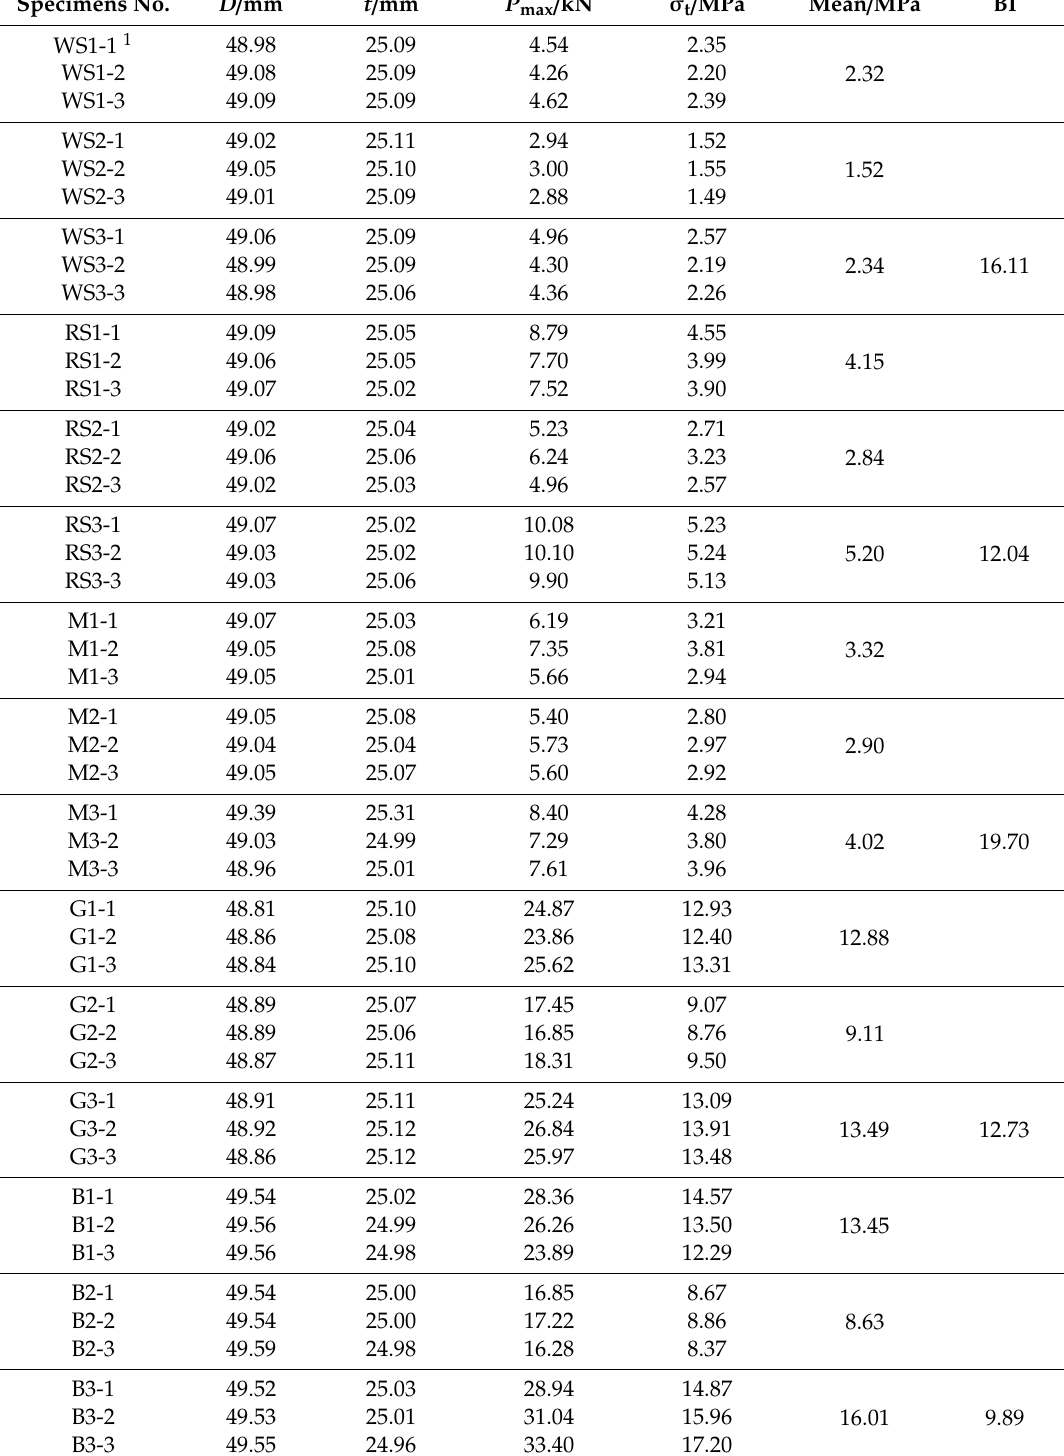
Table 2. Specimen dimensions and the Brazilian test